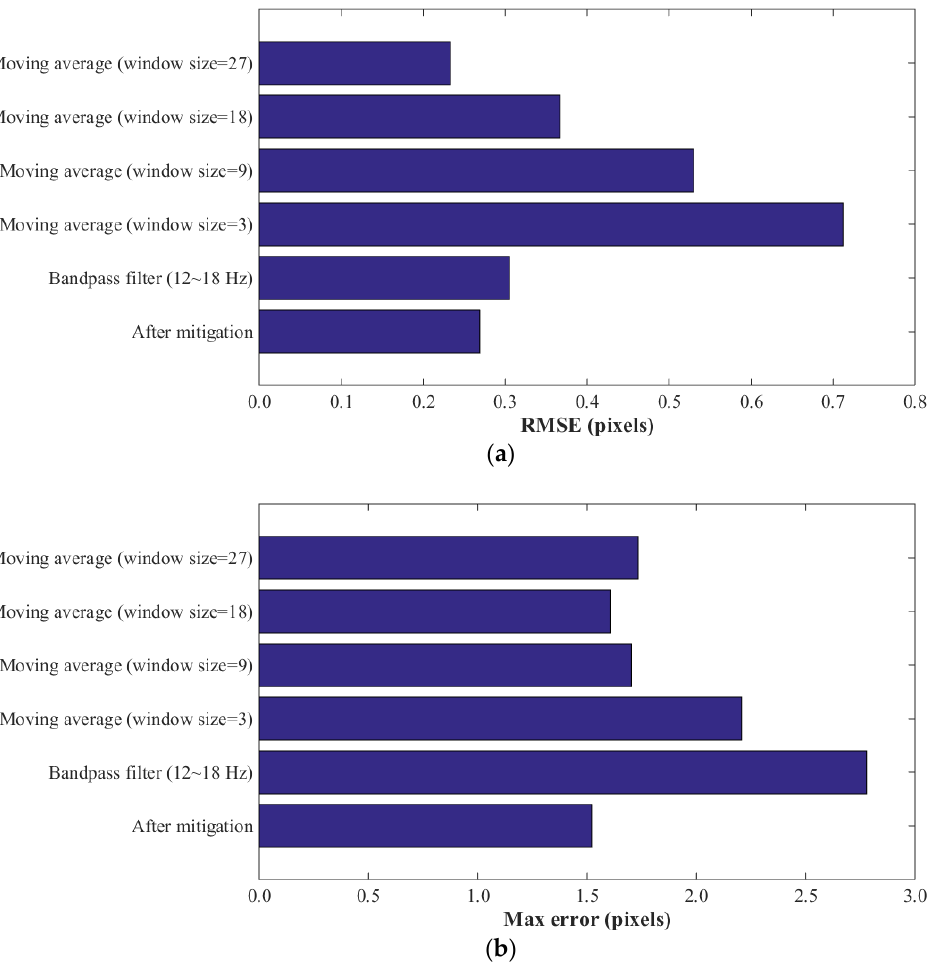
Figure 14. Statistical results of optical-turbulence error mitigation by different methods ( a ) RMSE